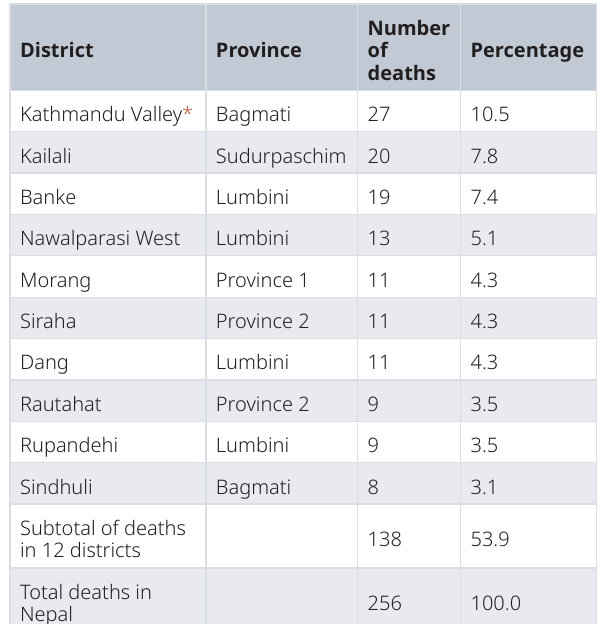
Table 2. Districts with highest number of road traffic deaths in Nepal during the COVID-19 lockdown.